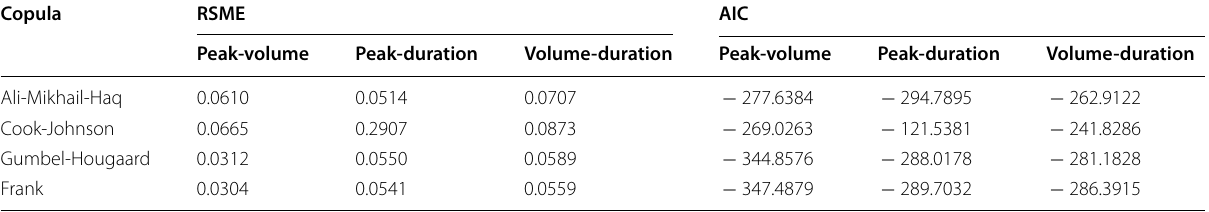
Table 6 Comparison of RMSE and AIC values for joint distributions through different copulas Copula RSME